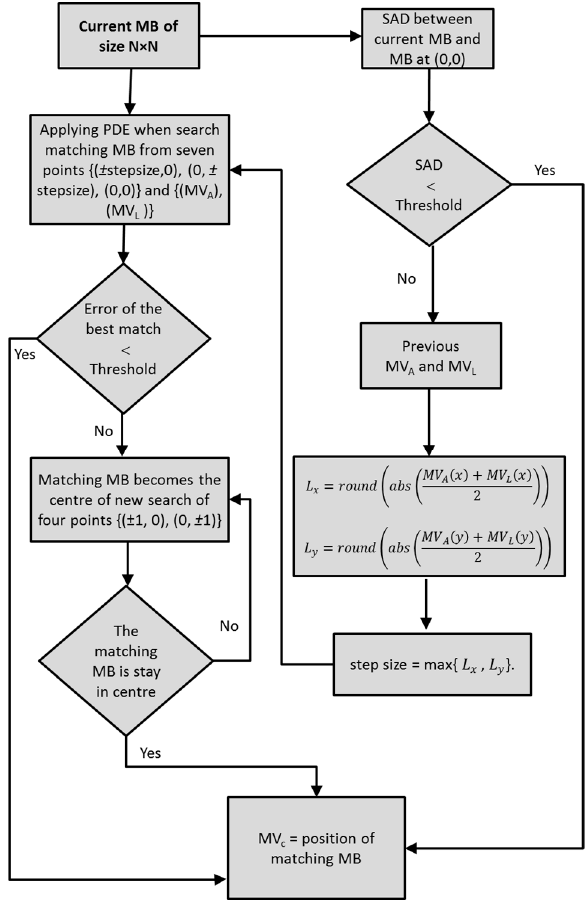
Figure 5. Block diagram of the proposed MPBMLY algorithm.